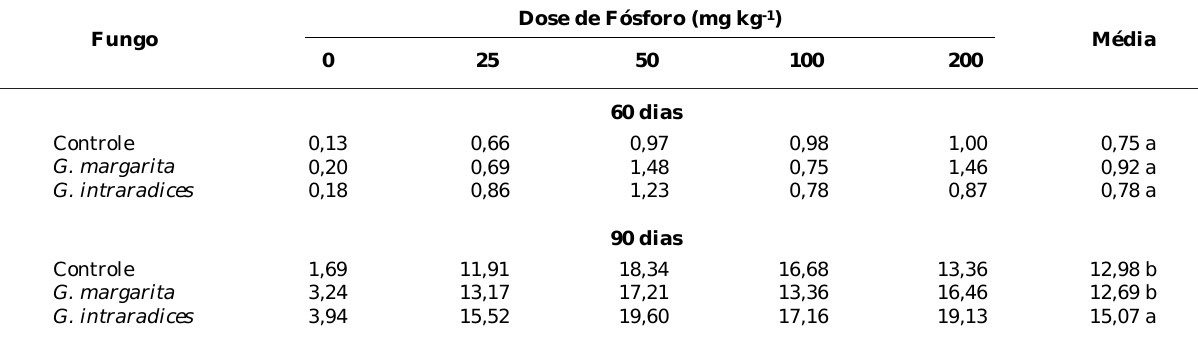
Quadro 2. Produção de matéria seca de vagens por plantas de soja (g vaso -1 ) inoculadas com fungos micorrízicos arbusculares ( G. margarita ou G. intraradices ) ou não inoculadas (Controle), sob doses crescentes de fósforo, aos 60 e 90 dias do transplantio